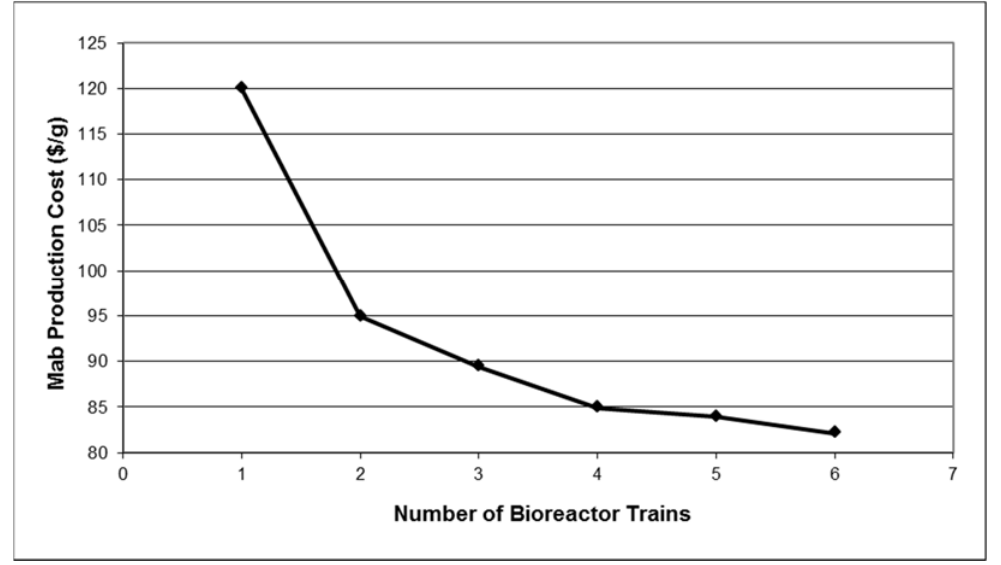
Figure 5. Production cost of MAb as a function of the number of bioreactor trains.